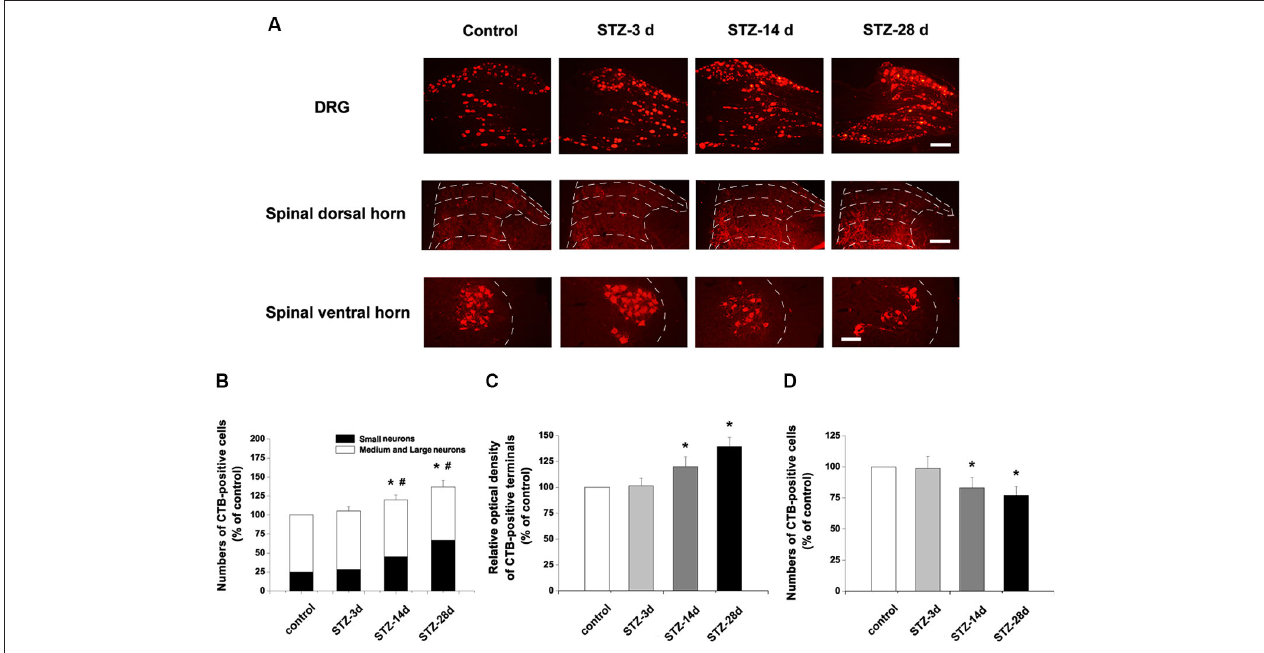
25.2% in the control, 27.1% in STZ-3d, 37.7% in STZ-14d and 46.1% in STZ-28d groups. Mean ± SD, n = 6 rats for each group. * P < 0.05, comparing the numbers of CTB-labeled cells in diabetic rats with those in non-diabetic control rats. # P < 0.05, comparing the proportions of the small CTB-labeled DRG neurons in diabetic rats with non-diabetic control